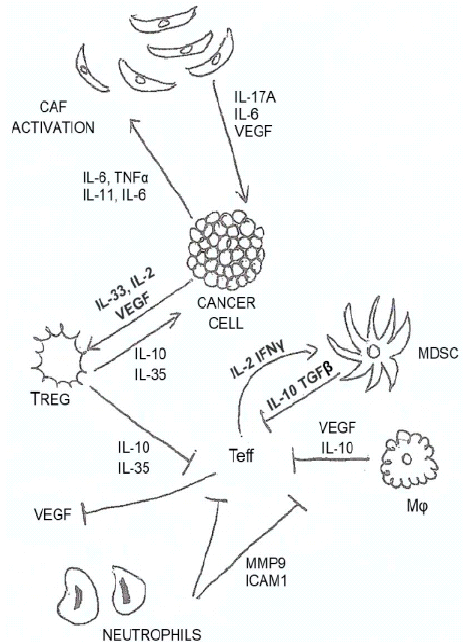
Figure 1. Most relevant cytokines in HNSCC. Th1 produces IL-2 and IFN- γ and recruits macro- phages; Th2 produces IL-4, IL-5, and IL-13 and recruits eosinophils and basophils; Th17 produces IL-17, IL-21, and IL-22 and recruits neutrophils; cytotoxic T cells produce IFN- γ and perforins and recruits NK cells; macrophages produce TNF, IFNa/b, IL-6, and IL-1b and recruits Tregs and MDSCs; neutrophils produce MMPs, ROS, peroxidase, IL-1, IFNg and TNF and recruits Tregs and